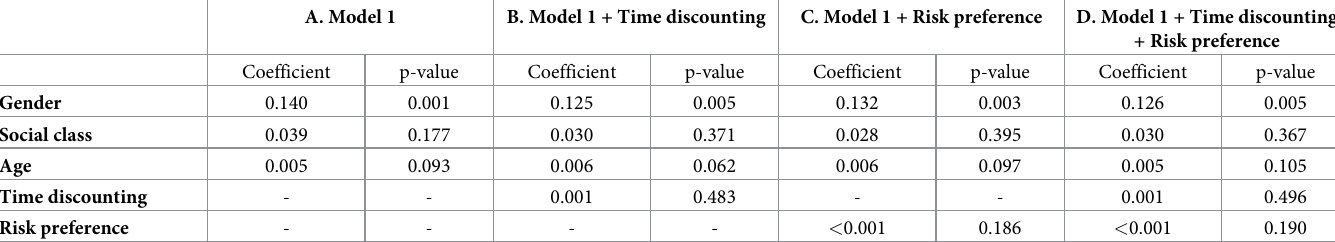
Table 4B) were significant mediators in the association between gender and speeding among our sample. Average direct effect mostly explained the gender-speeding association, which means that we could not find meaningful mediating factors. Table 2. LNAM regressions of